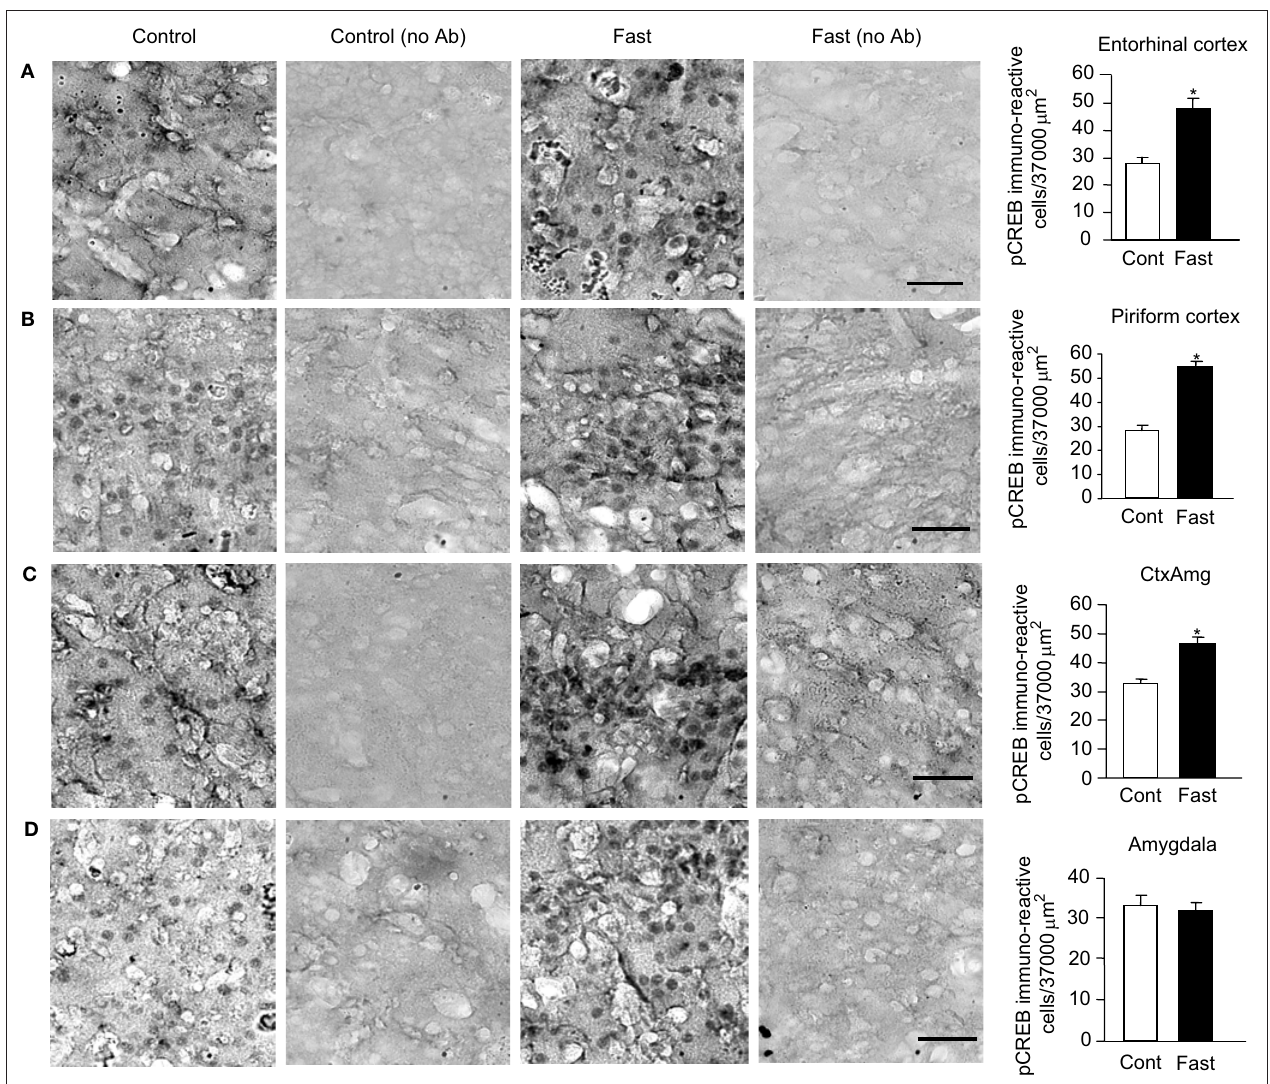
primary antibody, fast, and fast without a primary antibody (from left to right). The graphs on the right end show a group data for control vs. fast with a mean ± SEM. Calibration: 50 μ m (applies to all photomicrographs). * p <